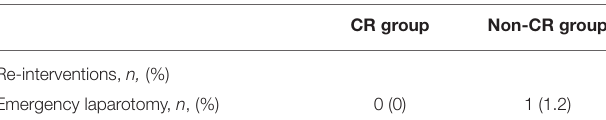
TABLE 8 | Re-interventions.